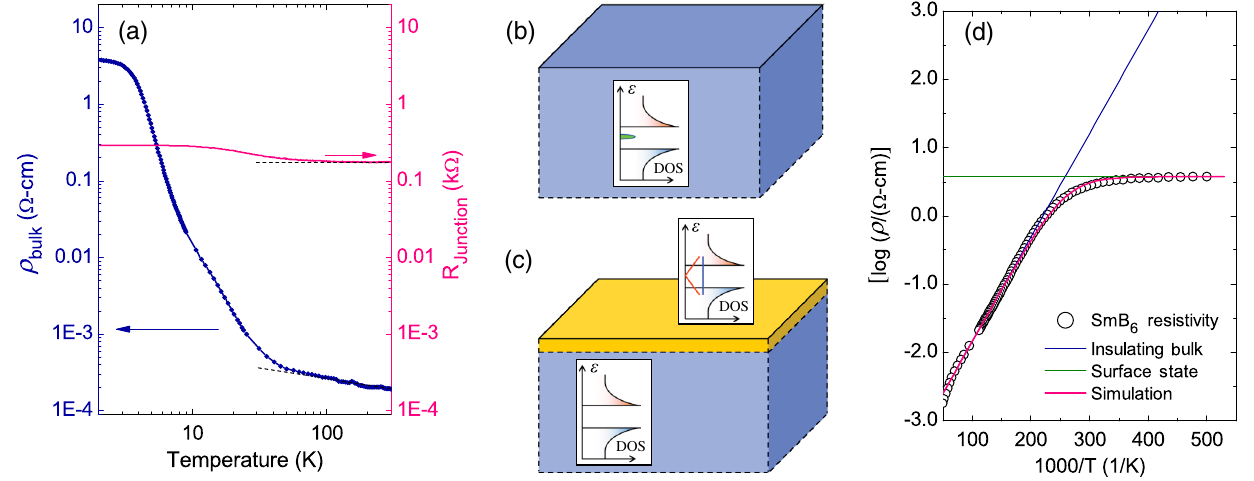
FIG. 3. (a) Temperature dependence of electrical resistivity of a SmB single crystal (blue data points) and the resistance of a 6 junction (pink). Compared to the 4 order-of-magnitude increase in the resistivity and a significant suppression below 4 K for Ag - SmB 6 crystals, the temperature dependence of the Ag - SmB junction resistance exhibits a rather different behavior with an single SmB 6 6 overall increase of about 2 in the measured temperature range and a low-temperature saturation below about 10 K . The dashed lines indicate that the junction resistance holds a constant value at temperatures above about 10 K , while the resistivity of bulk single without the presence of a crystals shows an activation behavior in the same temperature range. (b) Schematic view of the DOS in SmB 6 surface state. It is expected that the coherent transport of the bulk in-gap bound states (green area) leads to the suppression in resistivity with the emergence of a surface state at low temperatures. The finite residue at temperatures below 4 K. (c) The DOS in SmB 6 resistivity of the material is due to the presence of a conducting surface state. Both topological surface states (orange) and conventional two-dimensional electron gas (blue) could lead to such a metallic 2D conduction. (d) Simulation of the measured resistivity in the scenario that a metallic-like surface state dominates the conductance at low temperatures. The overall conductivity is the sum of two conduction channels: the surface conduction (green) and the intrinsic bulk conduction (blue). The measured resistivity approaches the saturation point at a temperature of around 4